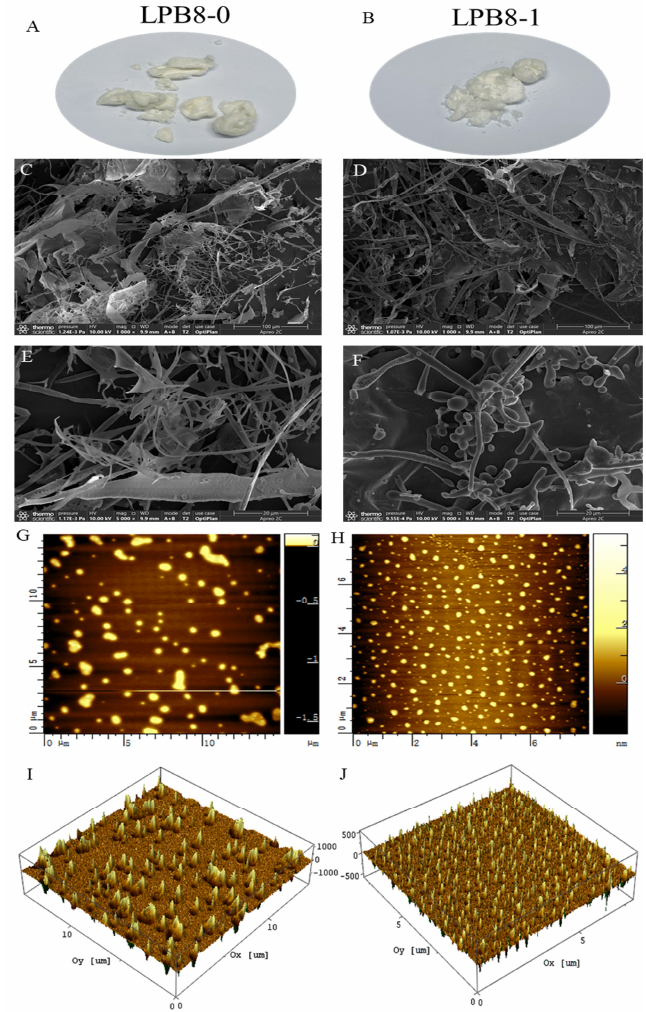
Figure 5. The appearances of LPB8-0 ( A ) and LPB8-1 ( B ); SEM images of LPB8-0 and LPB8-1 under 1000× ( C , D ) and 5000× ( E , F ) magnification; AFM showing the topographic features of LPB8-0 and LPB8-1, planar view ( G , H ) and cubic view ( I , J ).